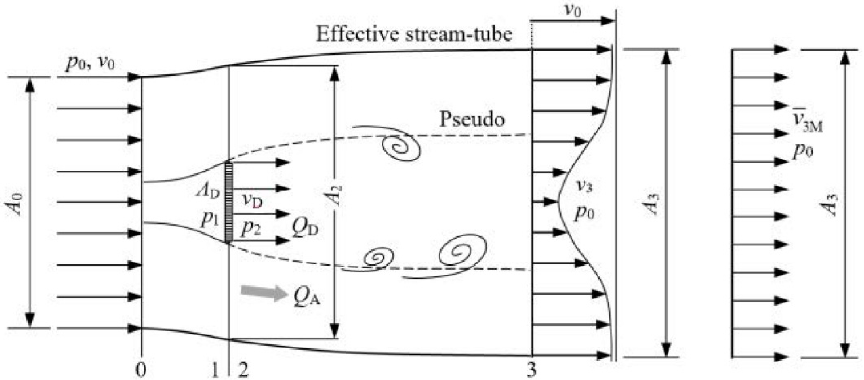
Figure 2. Actuator disc and the effective stream-tube (sufficiently large A 3 ).